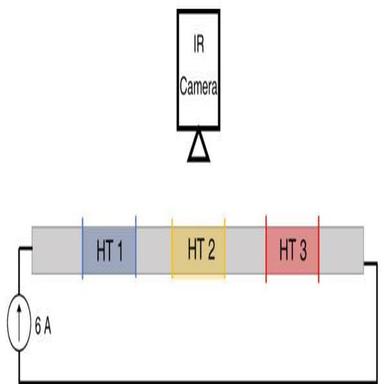
Schematic of the measurement approach for identifying the different electrical conductivity zones along the length of the FGM, using an infrared camera and an imposed electrical current.